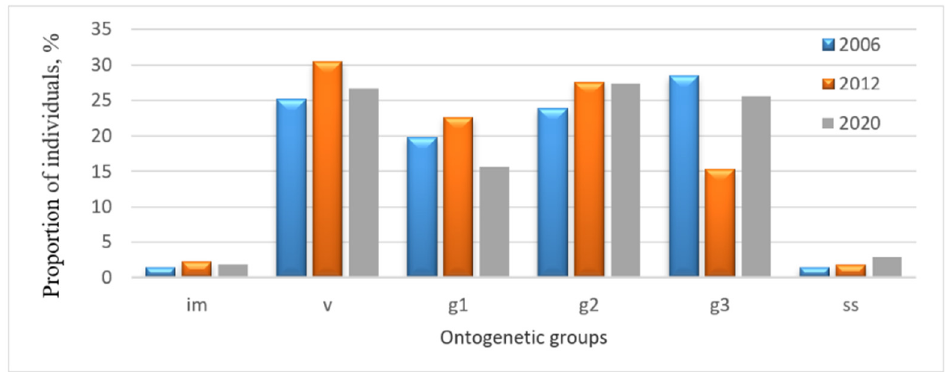
Figure 2. Age structure dynamics of the P. chlorantha population in the Zhiguli State Nature Reserve: im—immature; v—virginal; g1—young generative; g2—mature generative; g3—old generative; ss—sub-senile individuals.